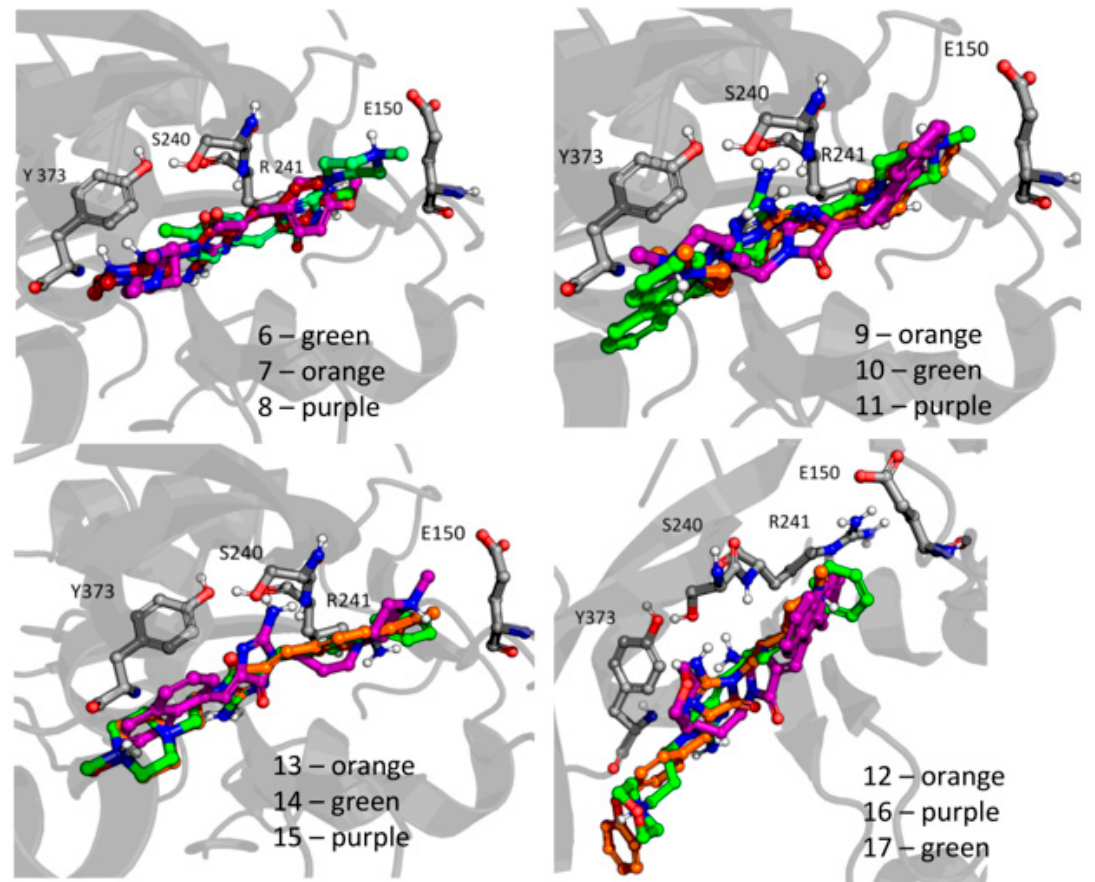
Figure 7. Docking poses of the studied compounds in the allosteric site of PBP2a (grid centered at S240).